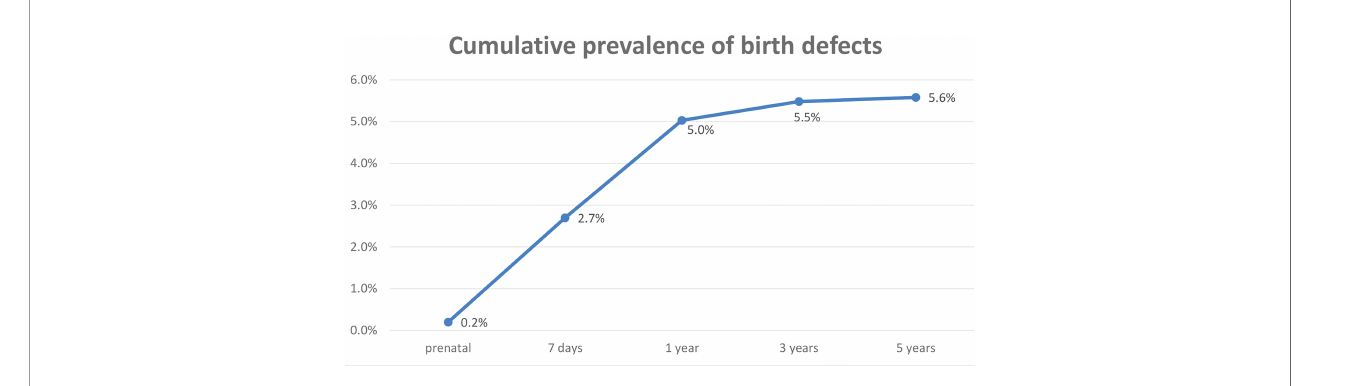
FIGURE 2 | Cumulative prevalence of birth defects in different follow-up